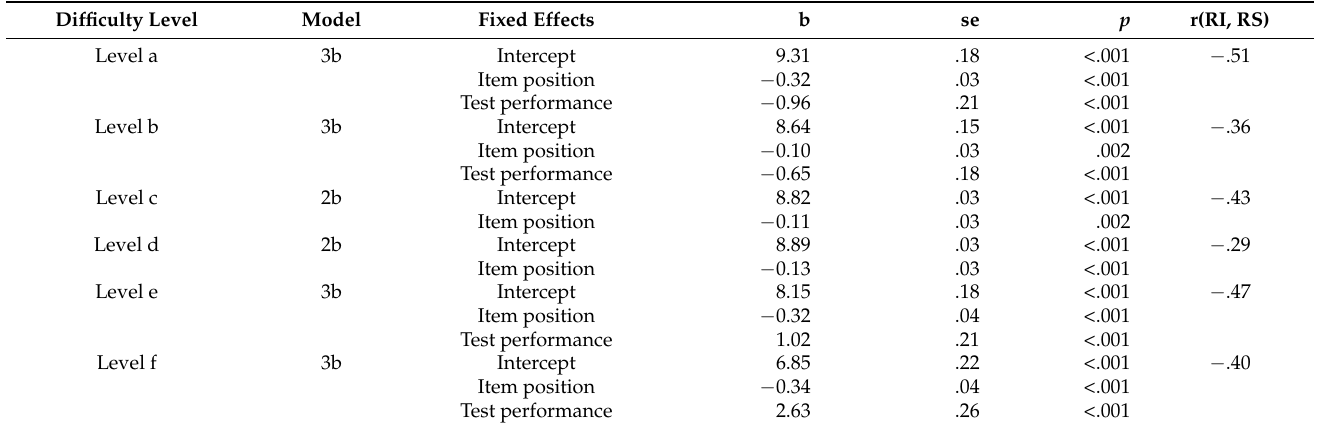
Table 4. Fixed effects and correlations between random intercept (RI) and random slope (RS) of the MLM with the dependent variable reaction times.